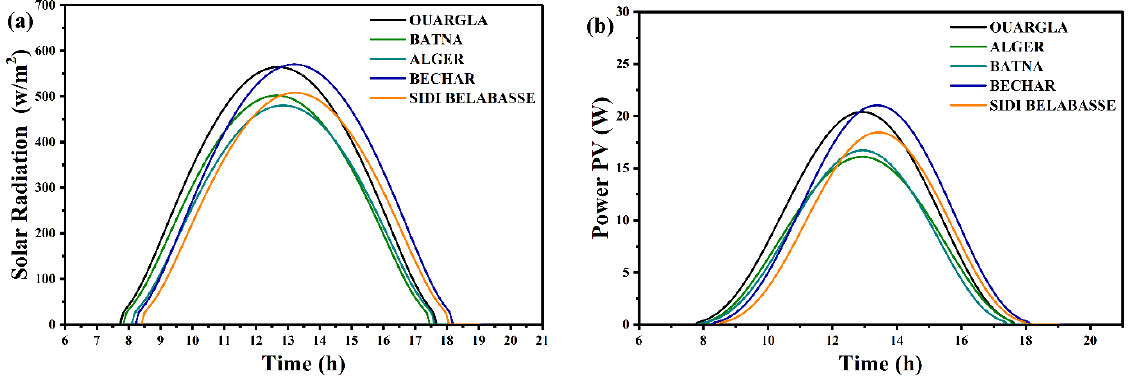
Figure 3. Daily evolution of ( a ) solar radiation and ( b ) power PV at different sites in Algeria (1 July 2022). The differences in radiation and power results between January and July can be ex- plained by the temperature variation that was higher in summer and lower in winter. Both the Ouargla and Bechar sites had maximum power PV. This result is justified by the dry climate of those areas that give higher values of radiation and, consequently, an important power PV. Figure 4 shows a PV efficiency evolution at different sites in Algeria during 1 January and 1 July. It is clear that the Ouargla site has the highest PV yield in the two selected days and the efficiency is more important in July than January. Figure 4. Daily PV efficiency at different sites in Algeria on ( a ) 1 January and ( b ) 1 July 2022.